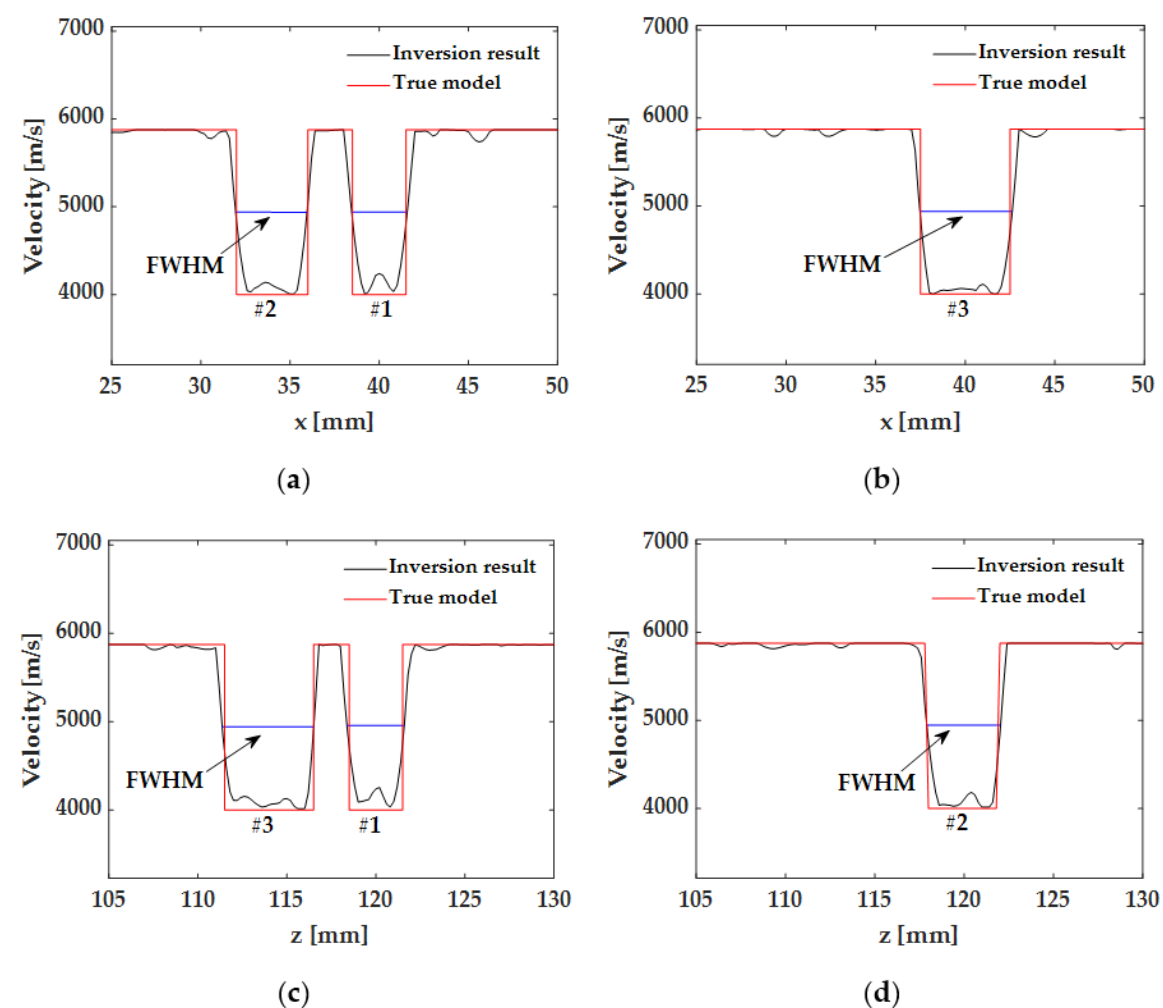
Figure 14. Cross sections ( a ) through #1 and #2 defects and ( b ) through #3 defect along the horizontal direction. Cross sections ( c ) through #1 and #3 defects and ( d ) through #2 defect along the vertical direction.